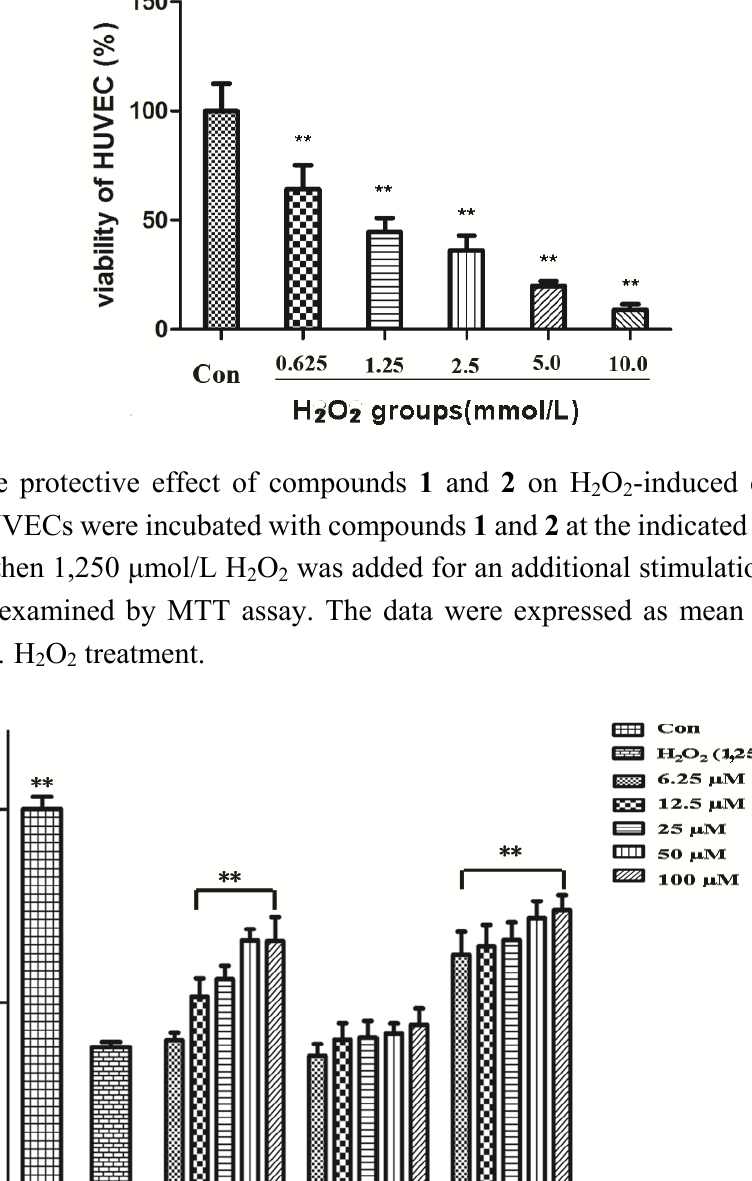
Figure 2. Effects of H